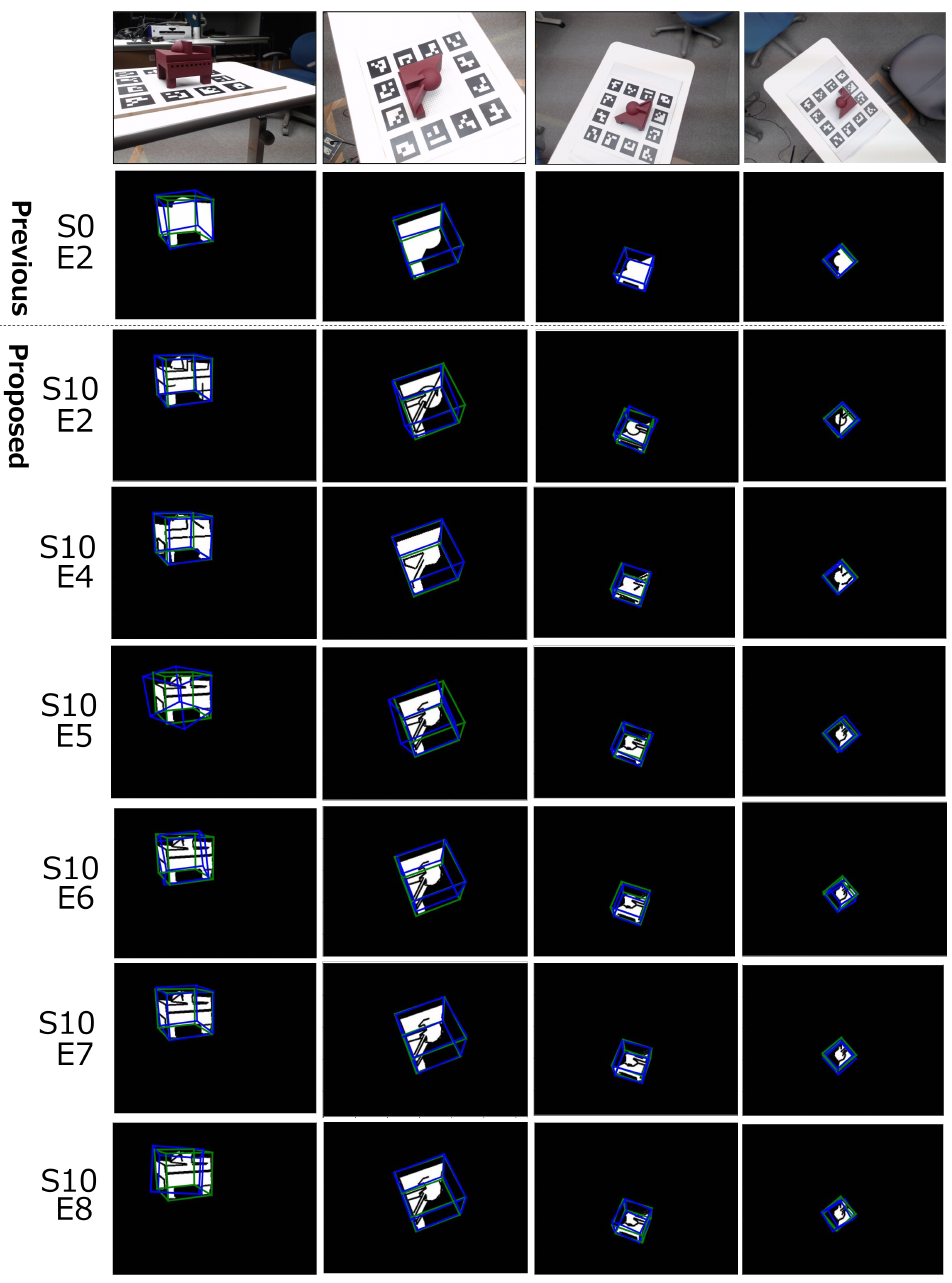
Figure 7. Examples of pose estimation results with the physical environment. The S0 row represents the result of the baseline method. Bounding boxes (BB) surrounding the object are calculated with pose information. Green BB is the ground truth pose and Blue BB is the estimated pose. Note that only the edge and mask result is represented because learning was not converged at several only edge